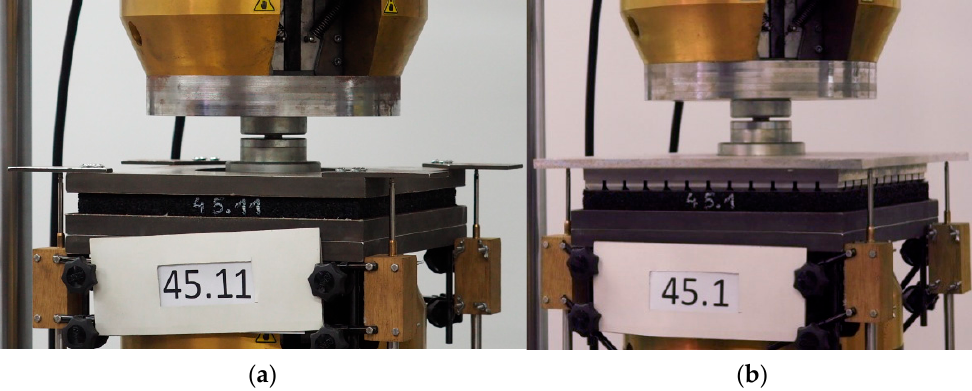
Figure 2. UBM tests: ( a ) with a flat ballast plate according to DIN 45673-5 [23]; ( b ) with a geometric ballast plate (GBP) according to EN 17282 [24]. The tested UBM specimen is a rubber-based mat no. 45, 20 mm thick.